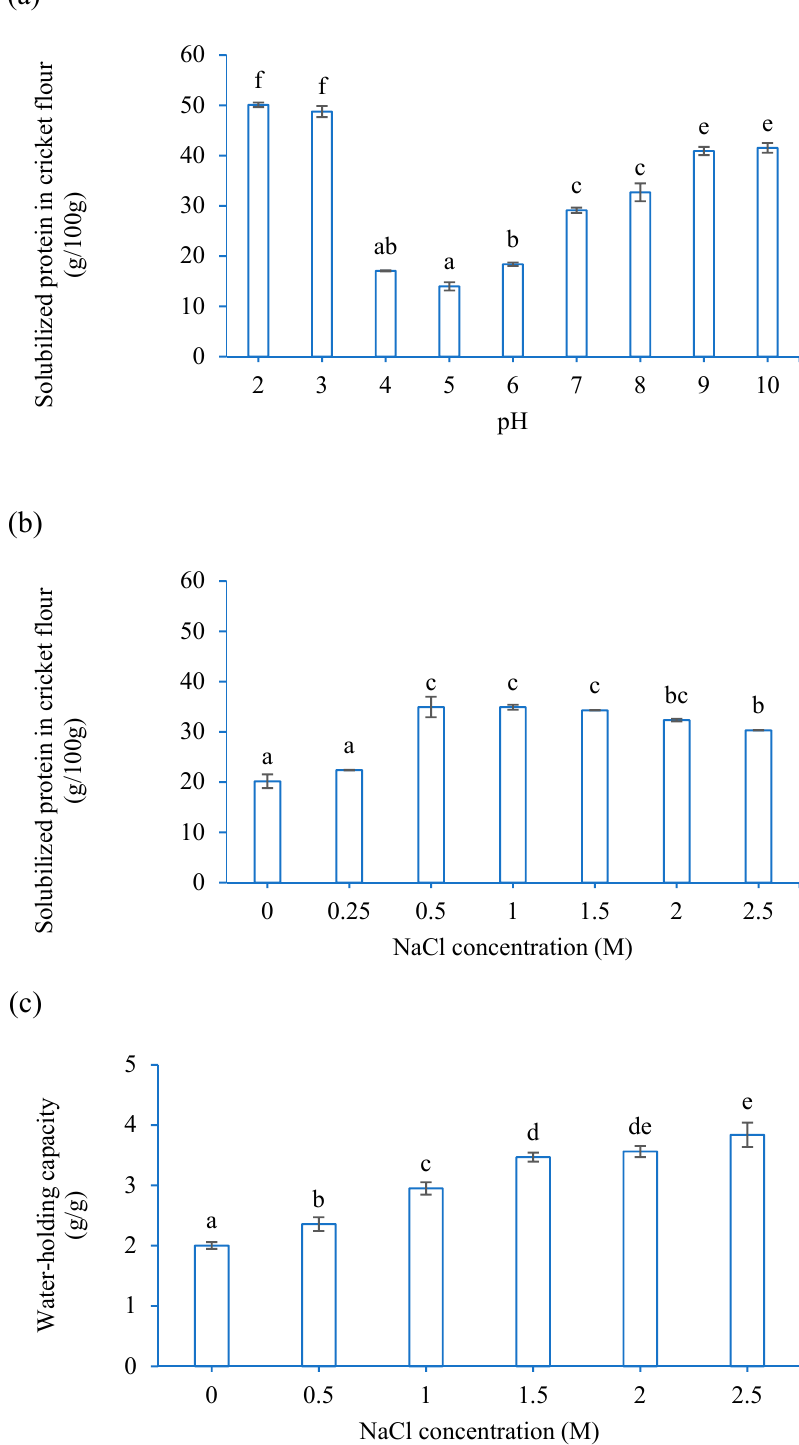
Figure 1. ( a ) Effect of pH on protein solubility, ( b ) effect of NaCl concentration on protein solubility, ( c ) effect of NaCl concentration on water-holding capacity. Significance differences ( p < 0.05) are Figure 1. ( a ) E ff ect of pH on protein solubility, ( b ) e ff ect of NaCl concentration on protein solubility, ( c ) e ff ect of NaCl concentration on water-holding capacity. Signi fi cance di ff erences ( p < 0.05) are denoted by different lowercase letters a, b, c, d, e, denoted by di ff erent lowercase le tt ers a, b, c, d, e, f. The water-holding capacity of CF (Figure 1c) was found to be ⁓ 2 g/g, which is in line with the results from the previous study of Zieli ń ska et al. (2018) [57]. The water-holding